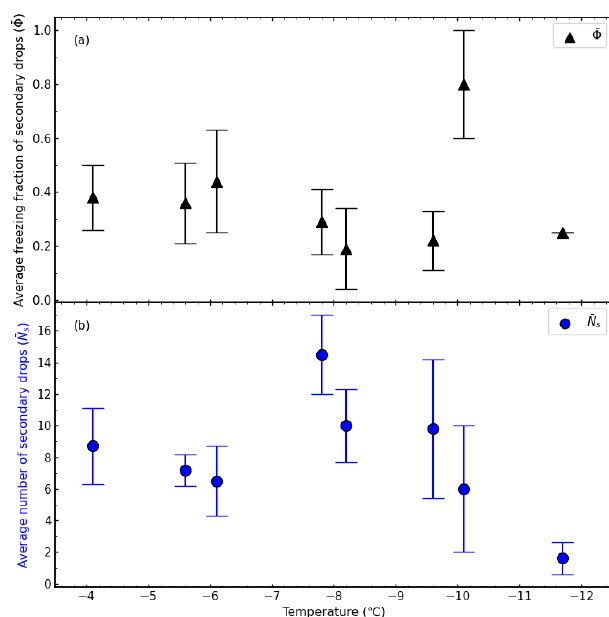
Figure 6. (a) The average freezing fraction of the secondary drops ( (cid:56) , black triangles) and (b) the average number of secondary drops ( N s , blue circles) as a function of temperature. Average data in- cluded both direct and partial collisions. The error bars represent the standard error in the freezing fraction or secondary drop num- ber for the temperature intervals which are listed in Tables A2 and